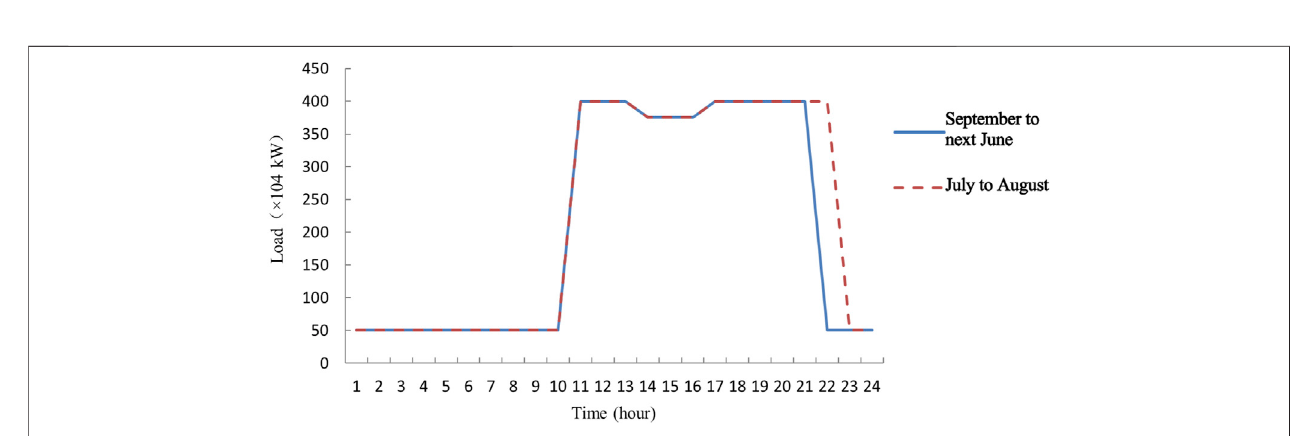
FIGURE 5 | Load curves of the DC output